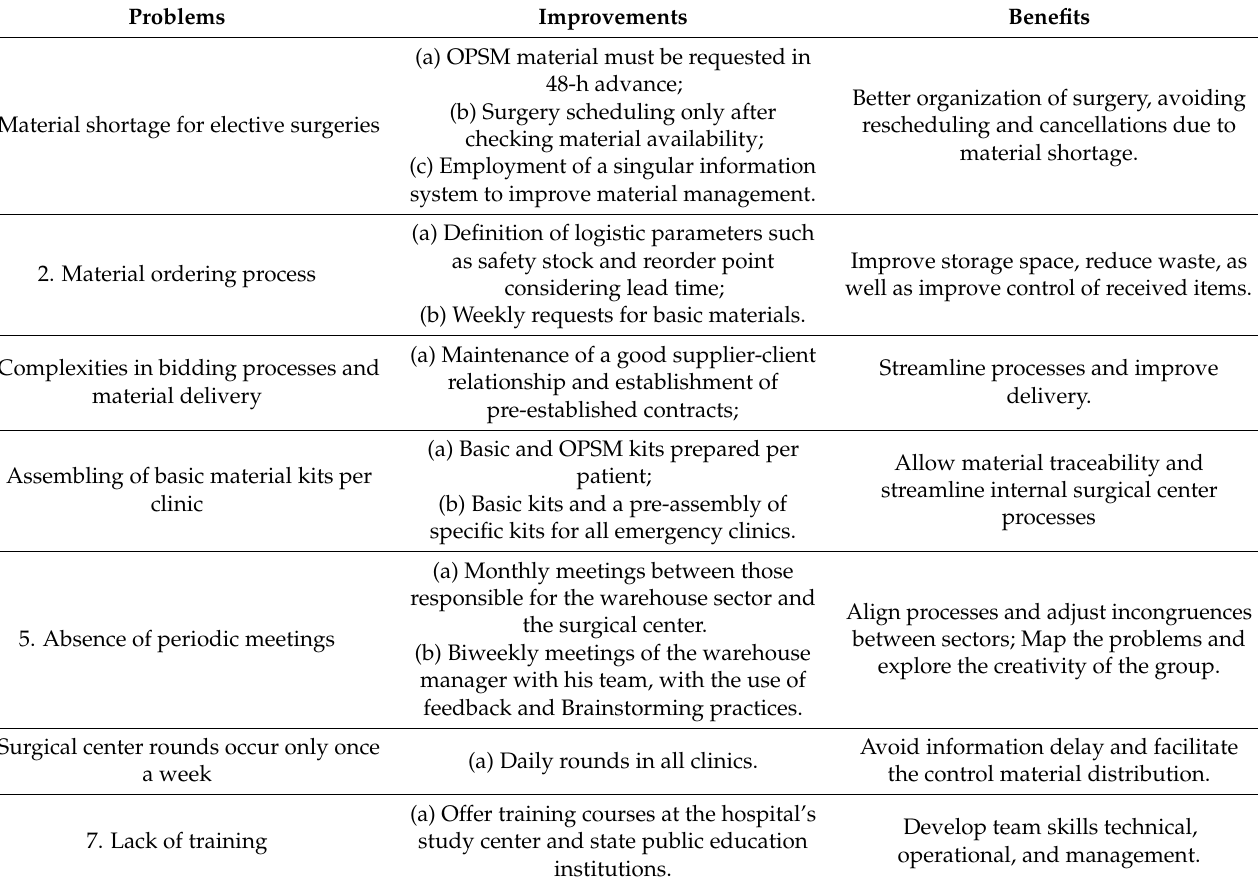
Table 2. Methodological